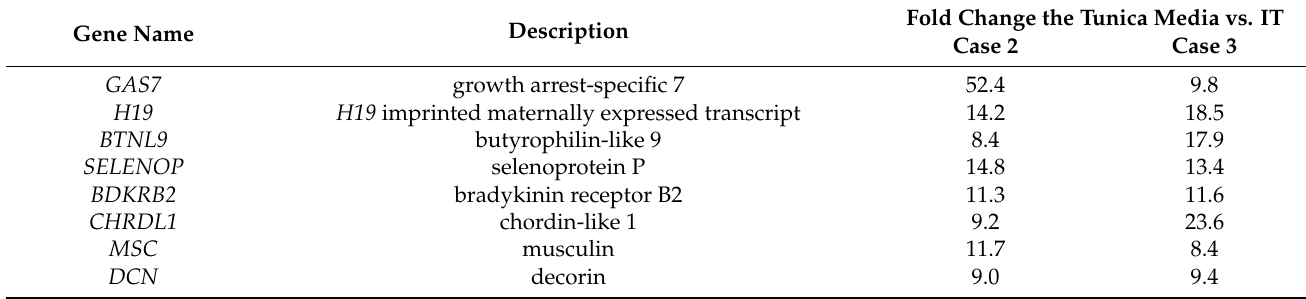
Table 8. Eight genes that overlapped and were enriched (>8-fold) in the tunica media compared to the intimal thickening (IT) of the closing DA tissues (Cases 2 and